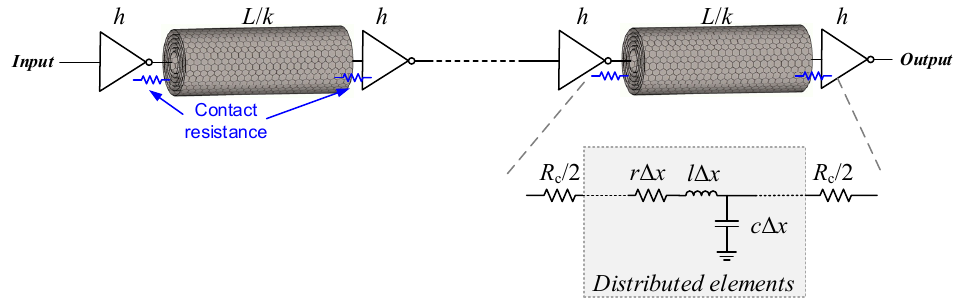
Figure 1. Repeater insertion in a long multi ‐ walled carbon nanotube (MWCNT) interconnect and the equivalent single ‐ conductor (ESC) model for one segment of the MWCNT interconnect.